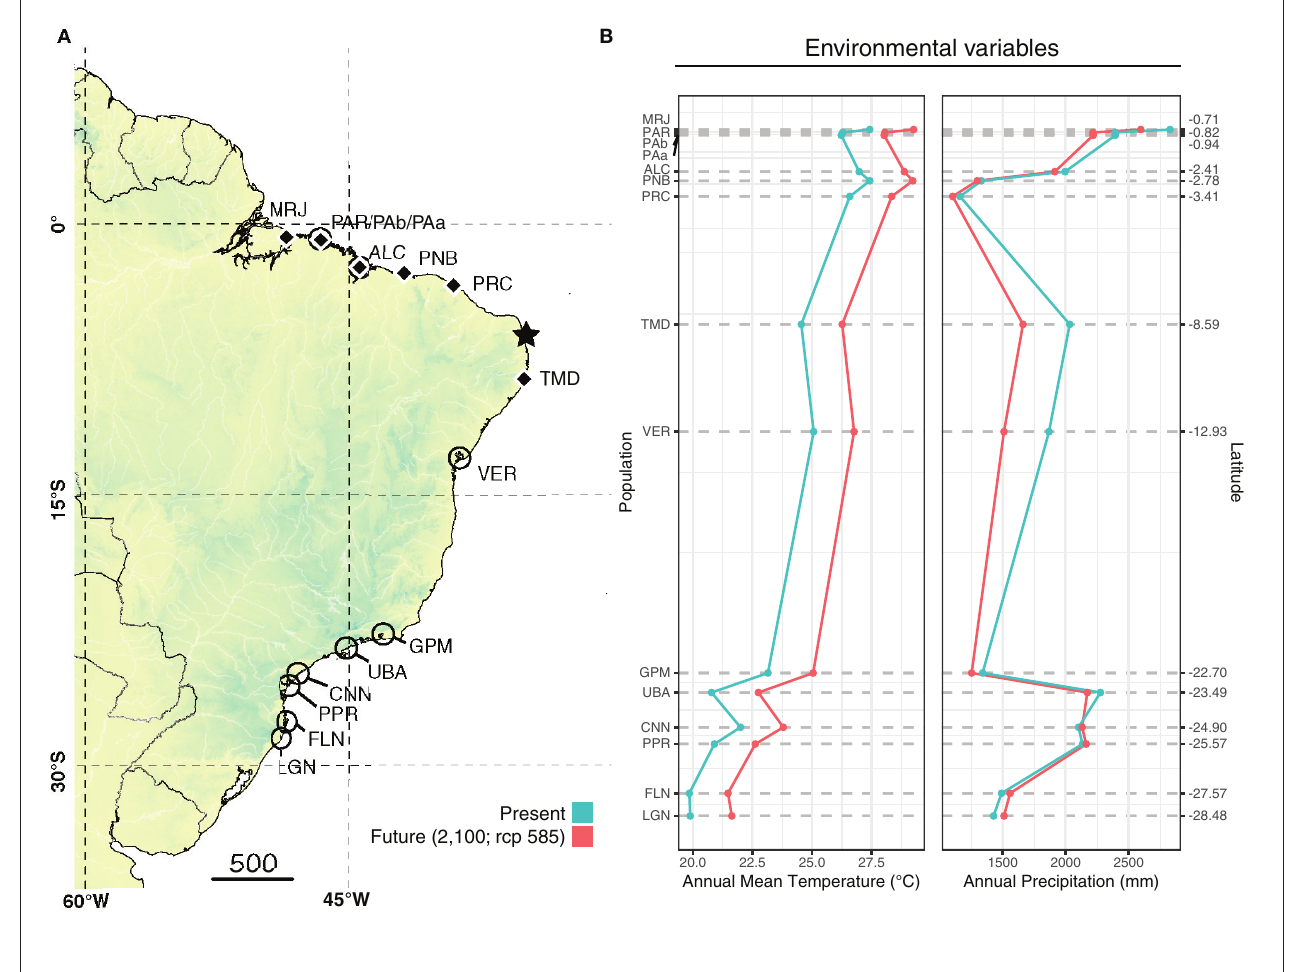
FIGURE 2 | (A) Sampled locations for Avicennia germinans (black diamonds) and Avicennia schaueriana (empty circles) and the northeastern extremity of South America (NEESA) (star). (B) Present and future (2100; SSP5-8.5) climatic conditions for each site based on WorldClim 2.0 ( Fick and Hijmans,